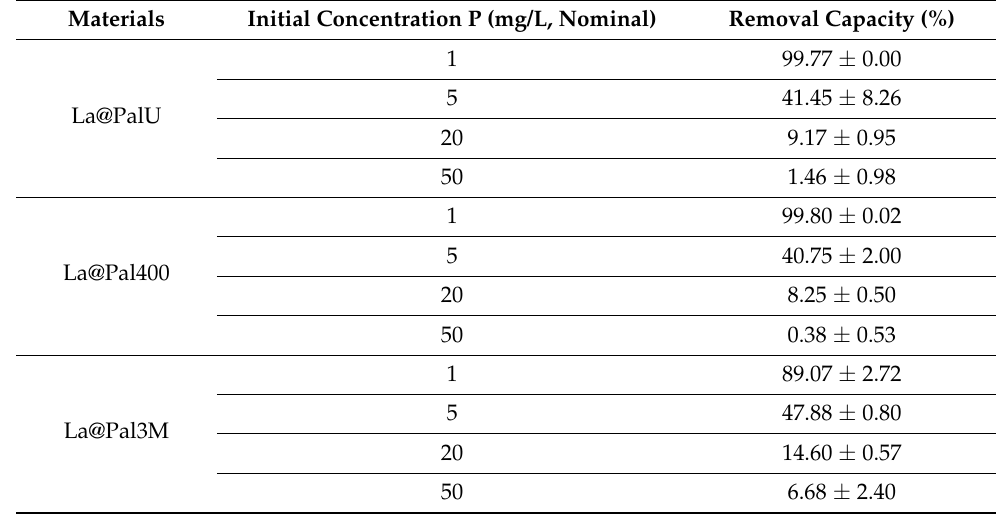
Table 2. Removal capacity of selective adsorbents in various initial concentration of P in aqueous solution.